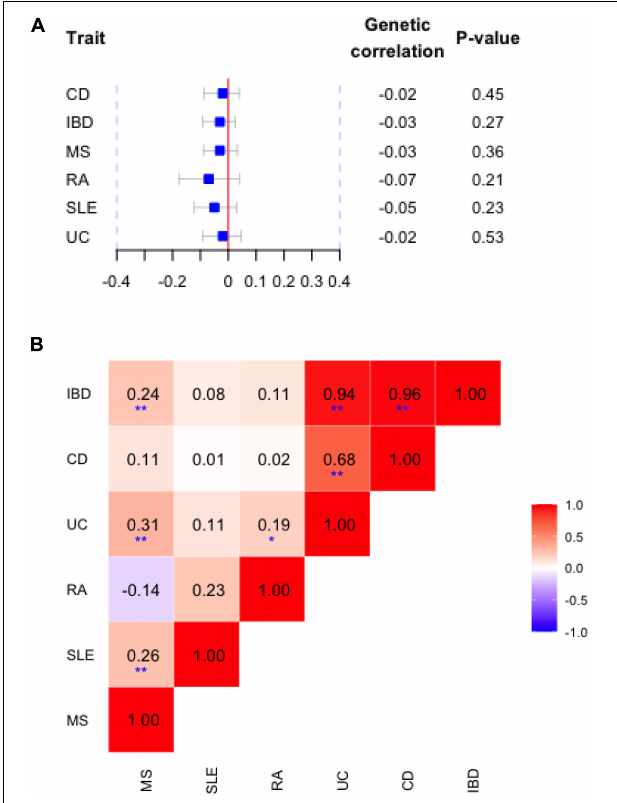
FIGURE 1 | (A) Genetic correlation between alcohol consumption (drinks per week) and risk of autoimmune inflammatory diseases. Blue squares and horizontal bars represent the point estimate and confidence intervals of genetic correlation with each disorder. (B) Pairwise correlation among autoimmune disorders. The color of each checker represents the magnitudes of correlation. A darker color represents a stronger correlation. **Bonferroni correct significance, *suggestive significance. IBD, inflammatory bowel disease; UC, ulcerative colitis; CD, Crohn’s disease; RA, rheumatoid arthritis; SLE, systemic lupus erythematosus; MS, multiple